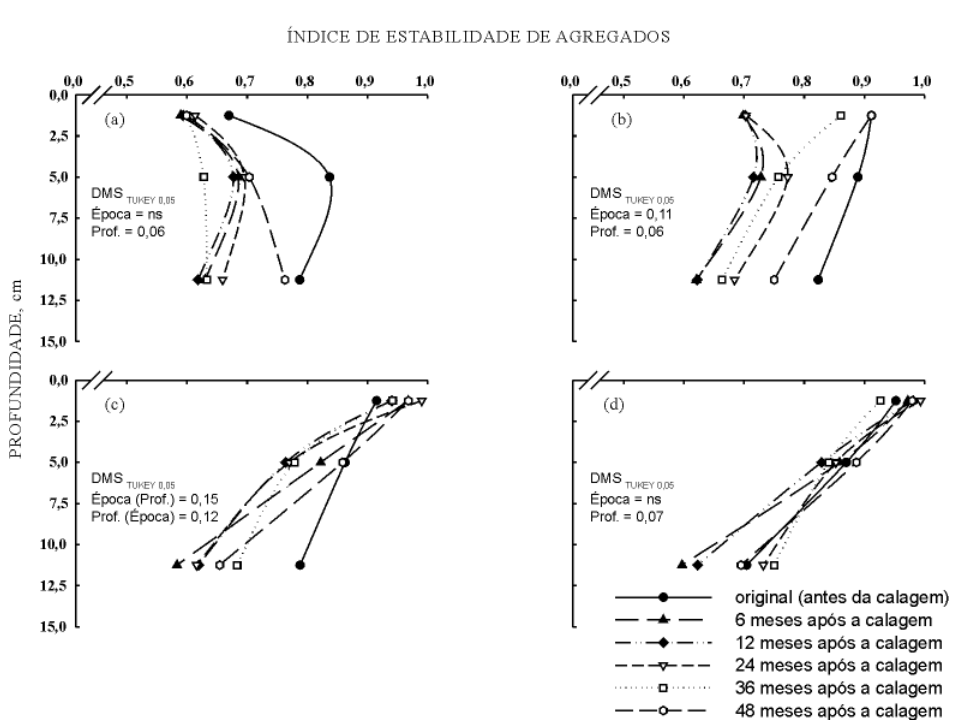
Figura 5. Índice de estabilidade de agregados em diferentes épocas de avaliação, profundidades e sistemas de manejo. (a) convencional durante 12 anos; (b) semeadura direta com revolvimento do solo a cada quatro anos; (c) semeadura direta durante oito anos; (d) semeadura direta durante 12